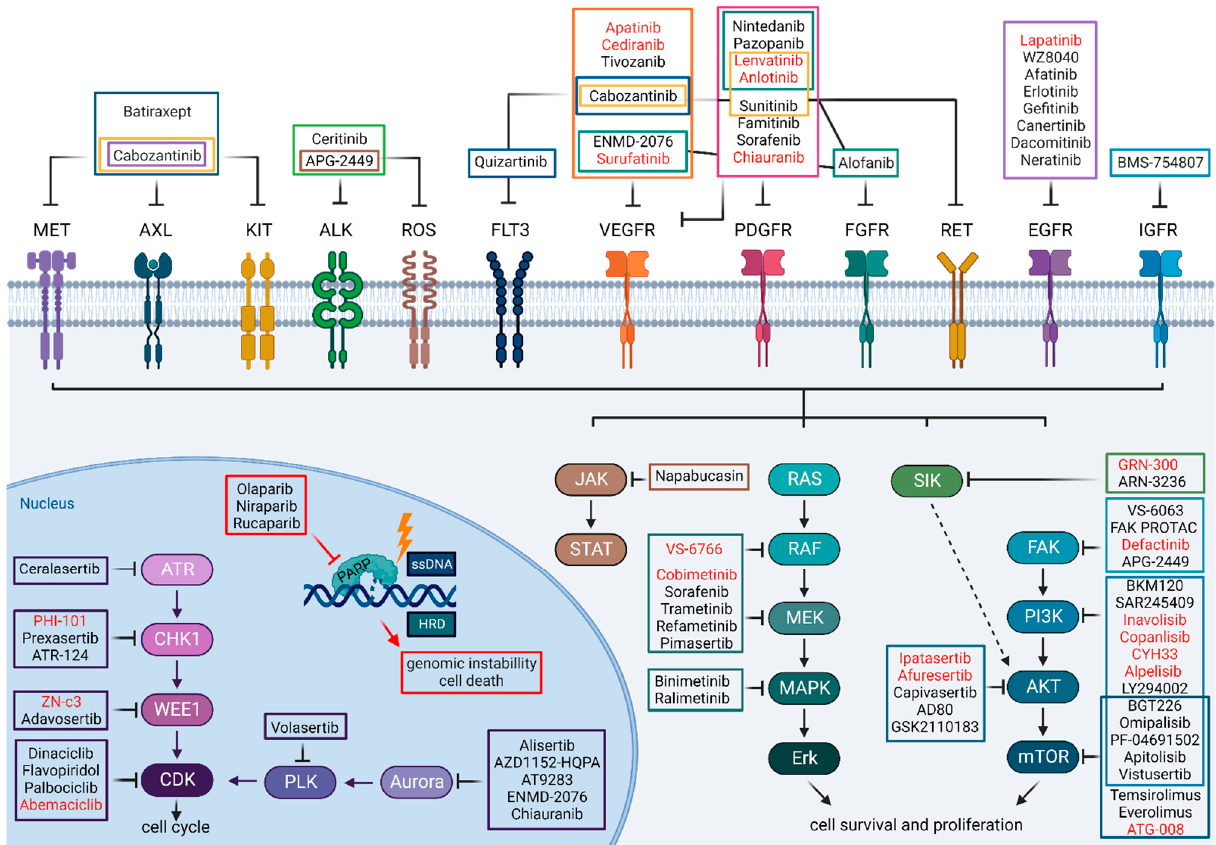
Figure 1. Kinase inhibitors and their targets discussed in this review. Inhibitors highlighted with red color are currently (November 2022) under clinical trials. The colors of the frames around the inhibitors represent the colors used for the kinases they inhibit. Created with BioRender.com.